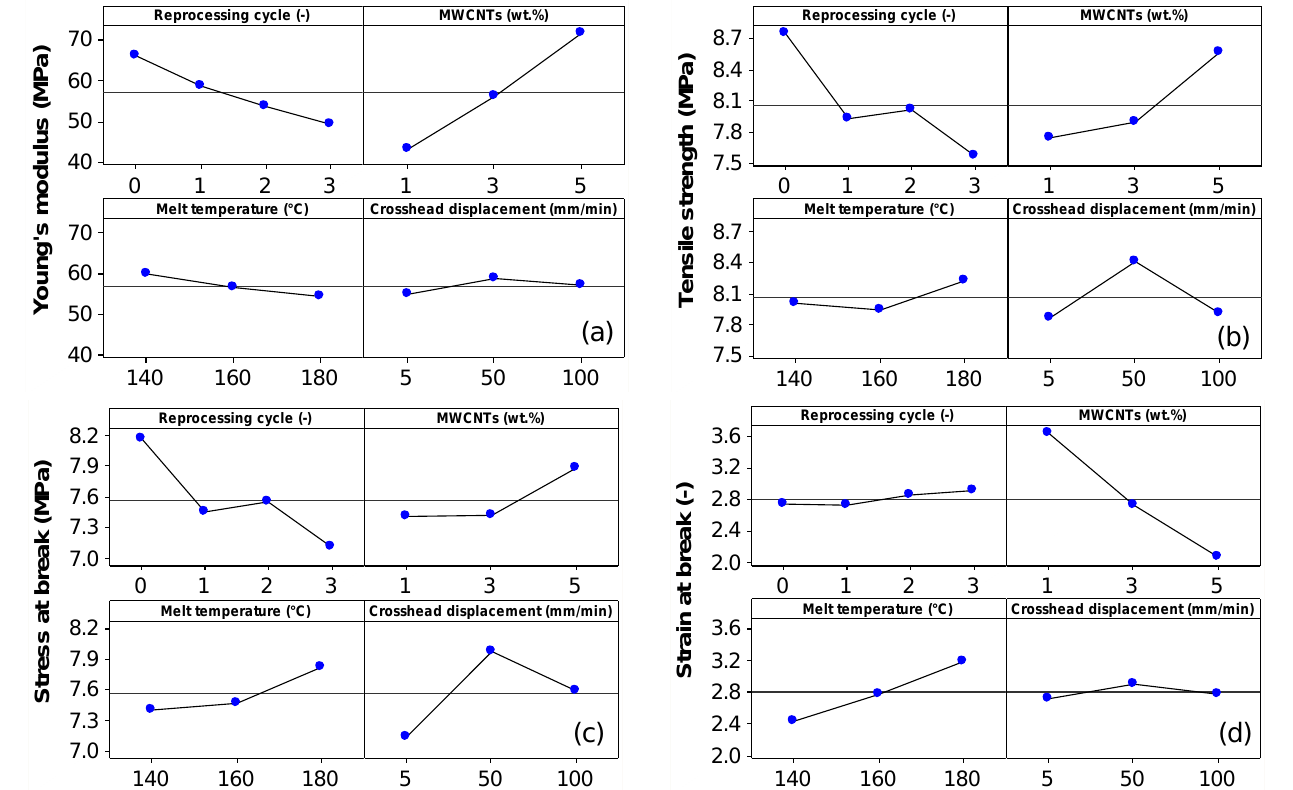
Figure 14. Main effect plot for the ( a ) Young’s modulus, ( b ) tensile strength, ( c ) stress at break and ( d ) strain at break for the EVA/MWCNT nanocomposites.